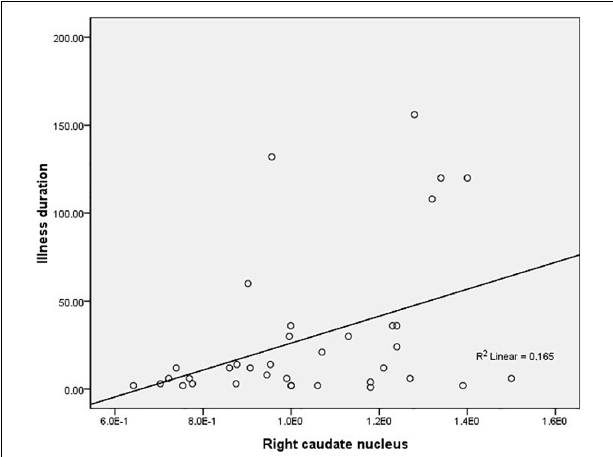
in female major depressive disorder (MDD)